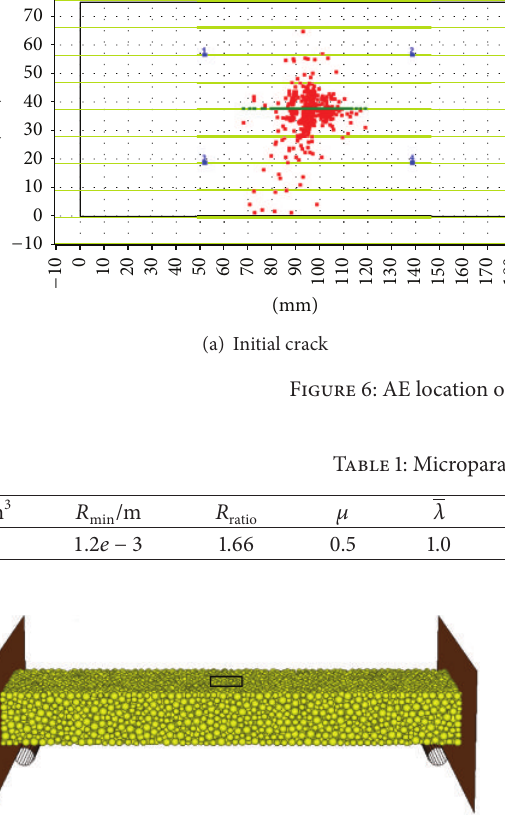
Figure 7: Computational model and its boundaries.